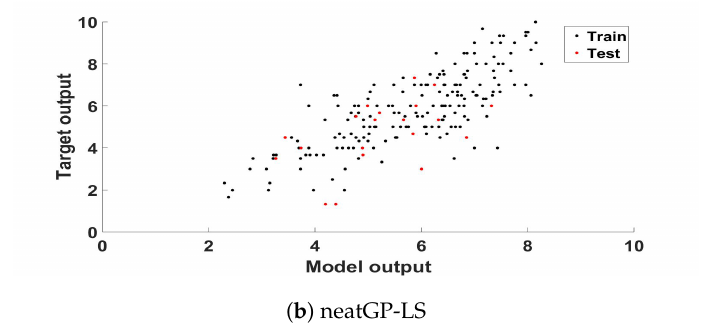
Figure 1. Scatter plot of the ground truth scores and the model outputs for the training and testing partitions of the best solution found computed for the dataset with a 1–10 scale.